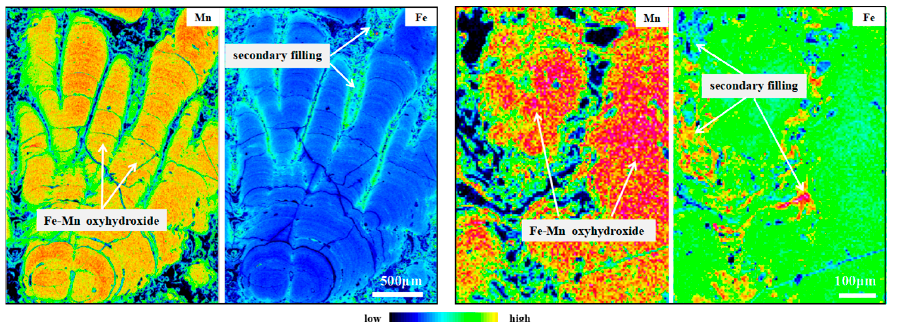
Figure 5. High resolution X-ray elemental intensity mapping of Layer 1 ( left ) and Layer 2 ( right ) of D07.